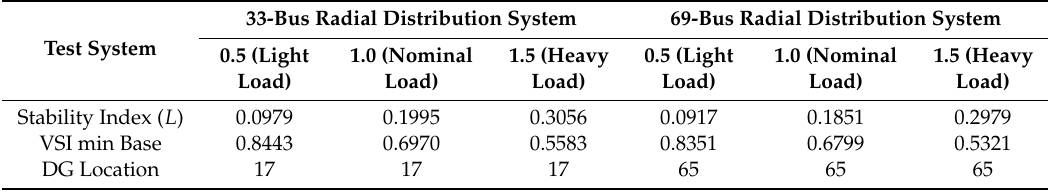
Table 1. The determination of DG bus location.